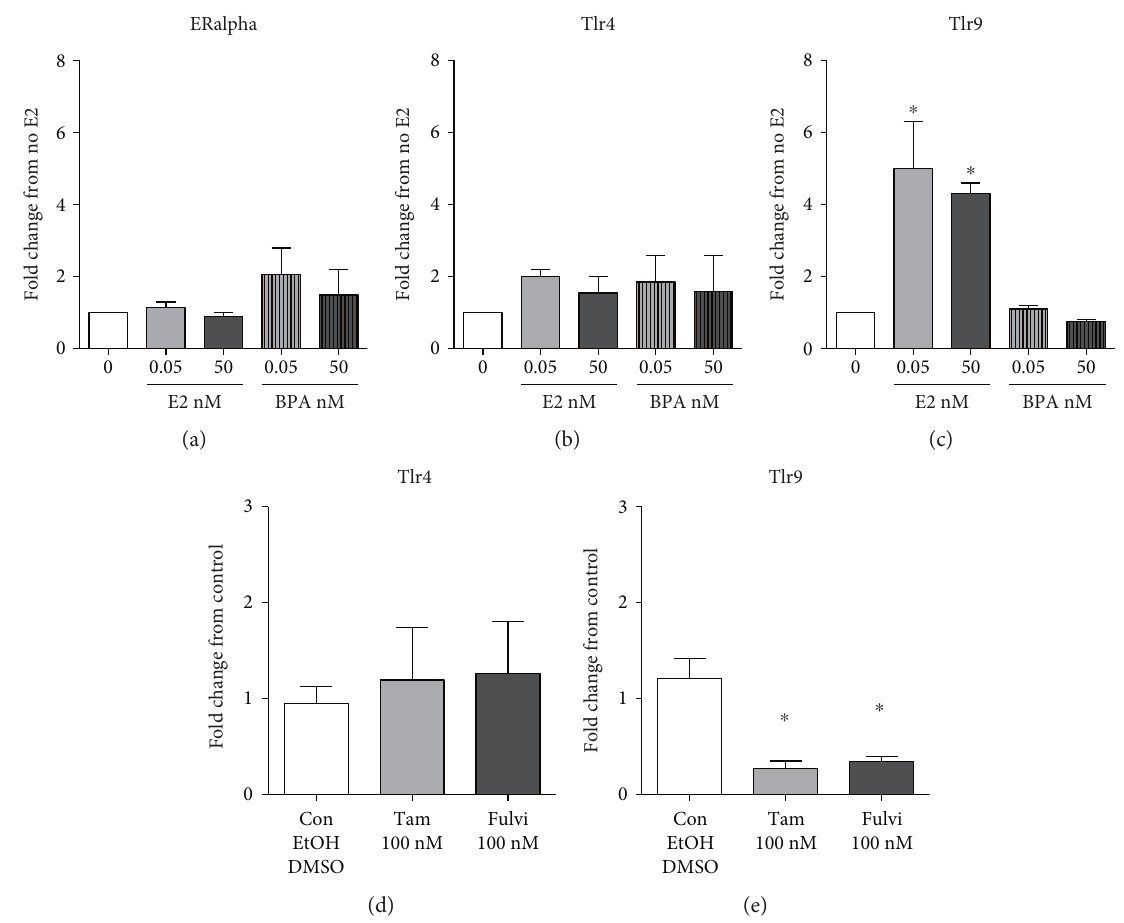
Figure 5: Estrogen but not BPA increases the gene expression of TLR9. We grew cDCs in the absence or presence of low (0.05nM) and high doses (50 nM) of E2 or BPA for 6-7 days. Then we measured the total RNA expression of ERalpha1 (a), Tlr4 (b), and Tlr9 (c) by real-time quantitative RT-PCR. Results are averages and SE of two cDC cultures. (d) and (e) show the results of the real-time quantitative RT-PCR for TLR4 and TLR9 transcripts in cDCs grown in the presence of tamoxifen or fulvestrant. Results are averages and SE of three cDC cultures. We calculated statistical signi fi cance by one-way ANOVA and post hoc multiple comparison test against 0 condition (no E2 nor BPA) in (a – c) and against control in (d-e). Since the three controls medium alone, ethanol, and DMSO gave comparable results, we pooled the data. ∗ represents p < 0 05 , ∗∗ for p < 0 01 , and ∗∗∗ for p < 0 001